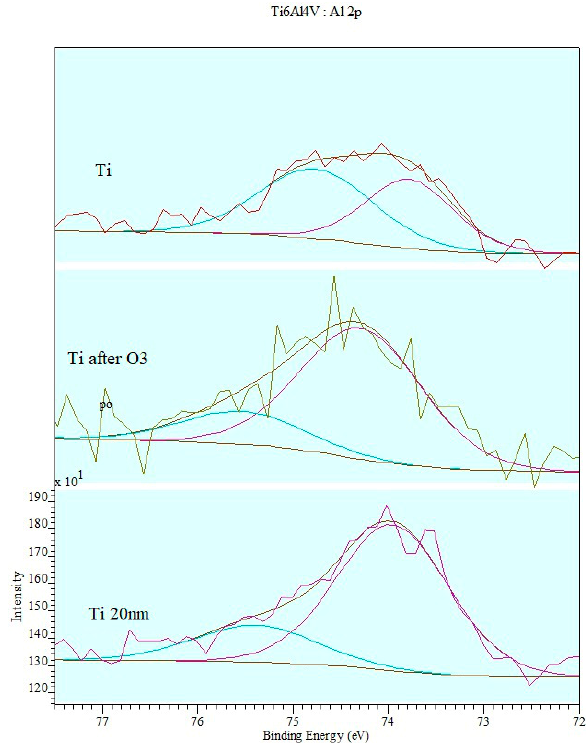
Figure 9. Deconvolution of XPS spectrum of Al2p band: Titanium alloy before ozone treatment (Ti), titanium alloy after ionic cleaning (Ti 20 nm) and titanium alloy after ozone treatment (Ti after ozone treatment).